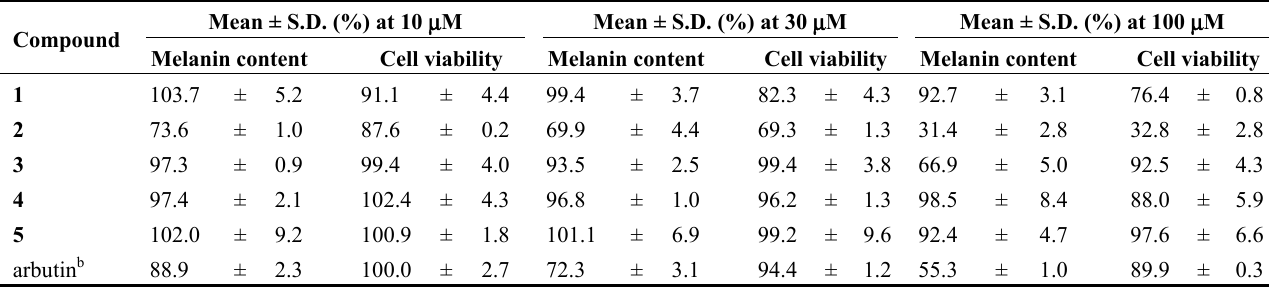
a Melanin content (%) and cell viability (%) were determined based on the absorbances at 450 nm, and 550 nm, respectively, by comparison with those for DMSO (100%). Each value represents the mean ± S.D. of